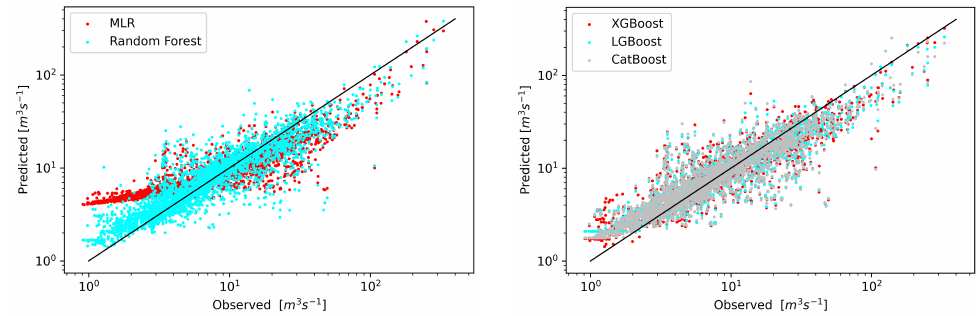
Figure 6. Forecast with default parameters based only on runoff data.